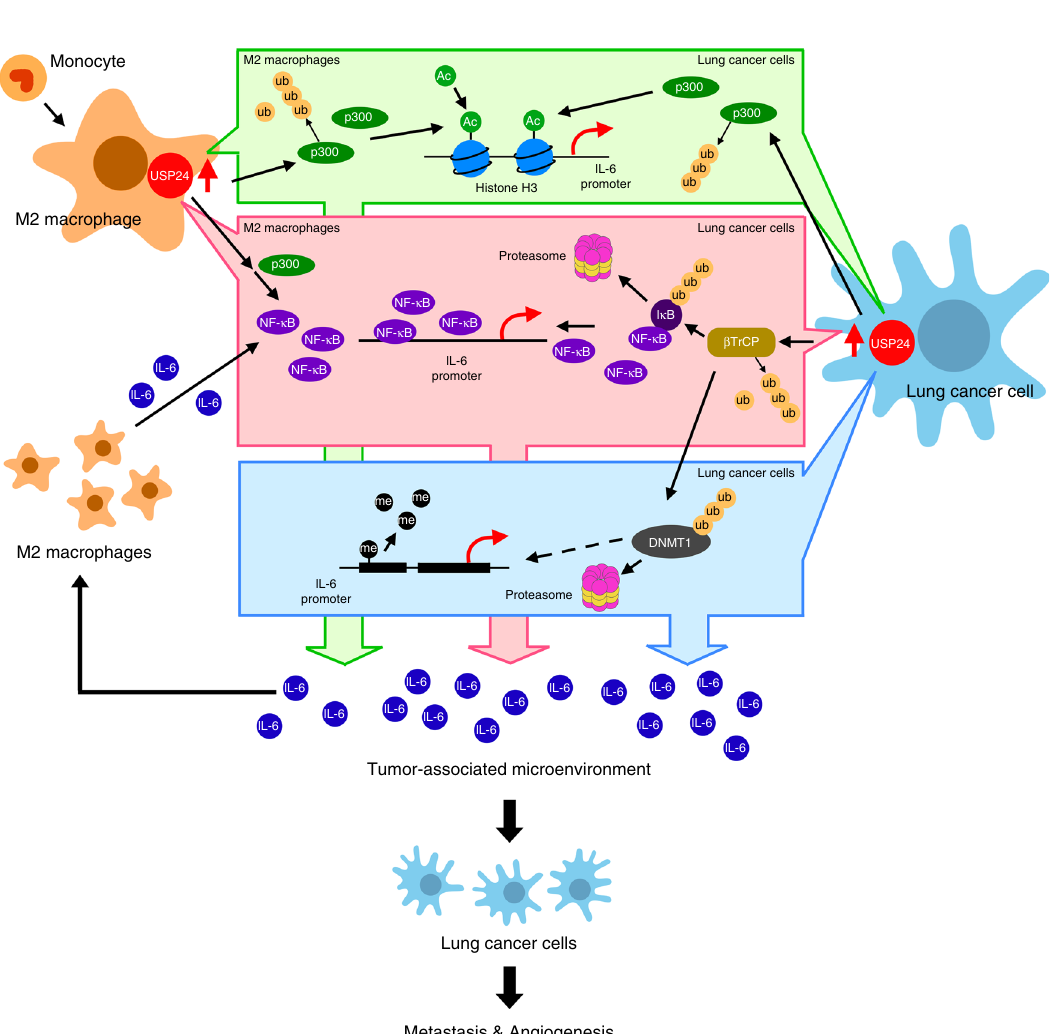
Fig. 9 Schematic summary of the role of USP24 in IL-6 mediated metastasis and angiogenesis. USP24 promotes IL-6 expression by increasing the levels of NF- κ B and histone H3 acetylation through stabilizes p300 in the M2 macrophages. In lung cancer cells, USP24 increases p300 and β -TrCP levels which promotes histone H3 acetylation, NF- κ B nuclear translocation and decreases IL-6 promoter methylation, thus resulting in the upregulation of IL-6 level in tumor-associated microenvironment and lung cancer